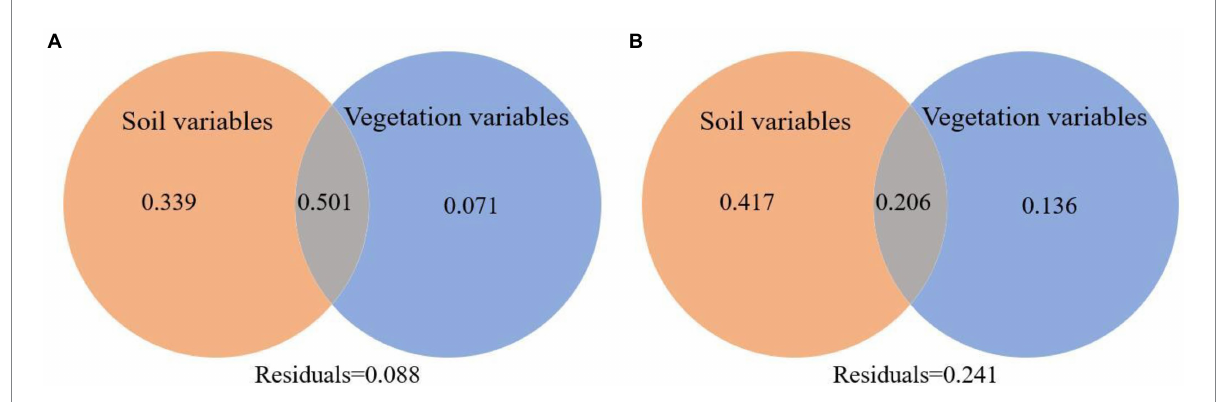
FIGURE 9 Variation partitioning of total variation in overall arthropods data in terms of the pure effect of the soil variables and vegetation variables and the joint effect of all variables considered ( A is the burned habitats; B is the unburned